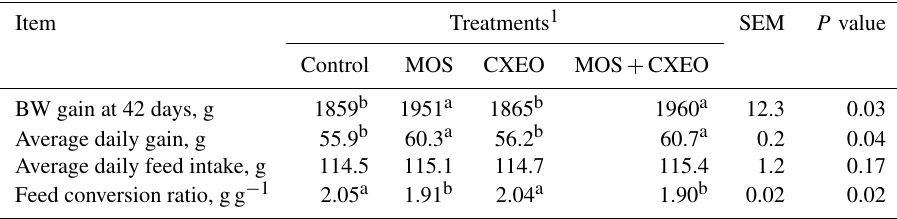
Table 2. Effect of mannan oligosaccharide (MOS) and Curcuma xanthorrhiza essential oil (CXEO) on the growth performance of finishing broilers subjected to heat